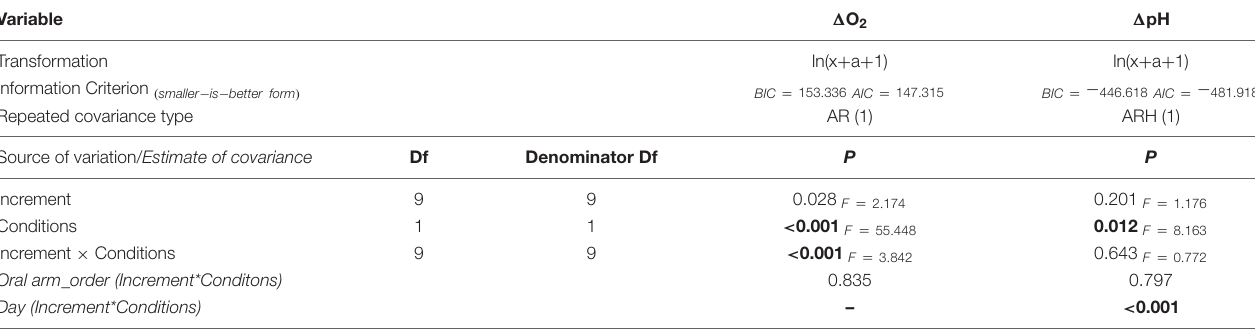
TABLE 1 | Repeated Linear Mixed Models (LMMs) comparing pH and oxygen (to ambient levels) between the two considered conditions (night and afternoon).